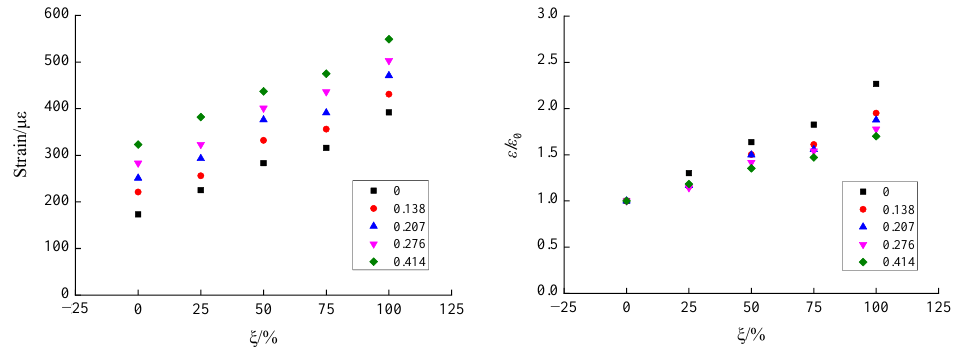
Figure 9. Variation trend of the influence of RA replacement rate on the shear strain of recycled concrete.